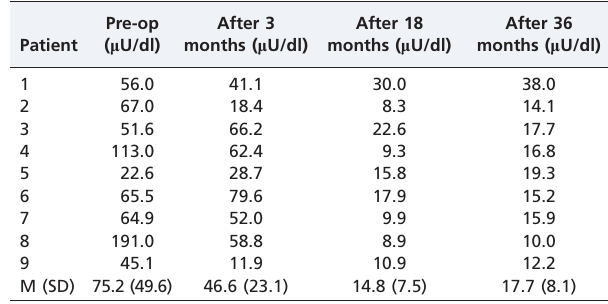
Table 6 - Post-prandial insulin levels: Comparison between preoperative values and values at 3, 18, and 36 months after surgery. All postoperative values were significantly lower ( p , 0.05). M= mean; (SD)= standard